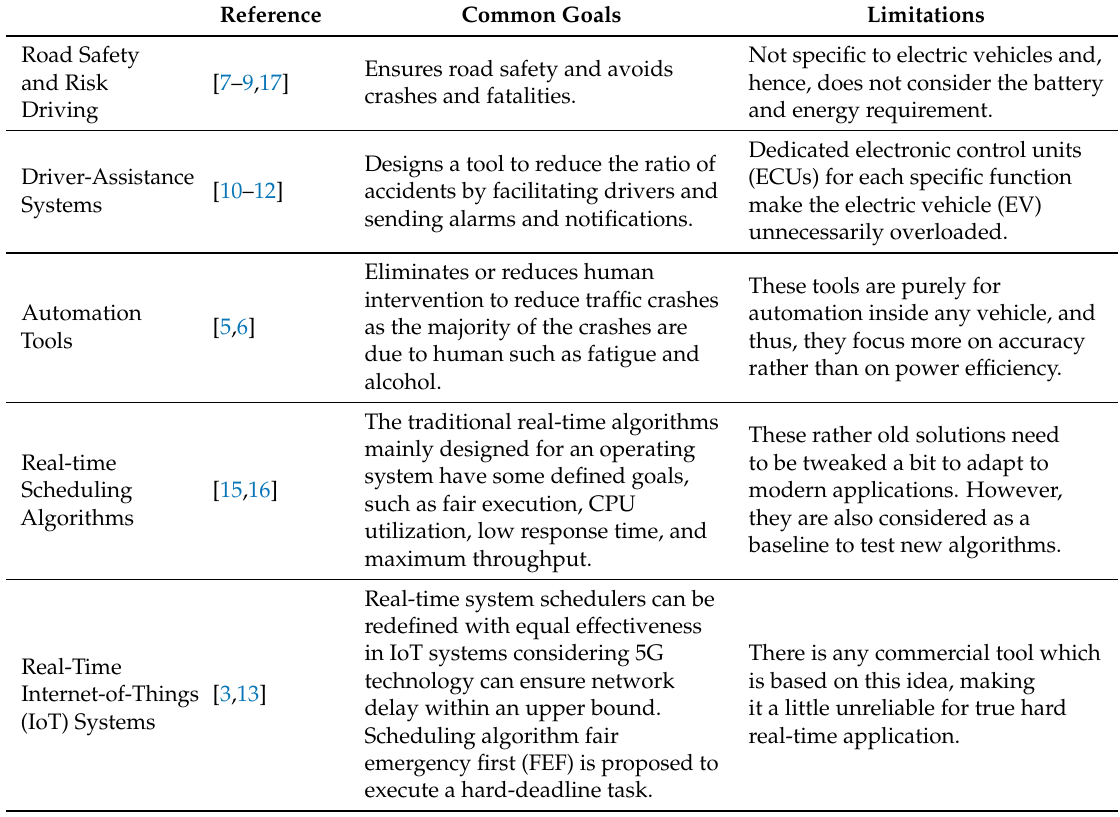
Table 1. Current position of state-of-the-art